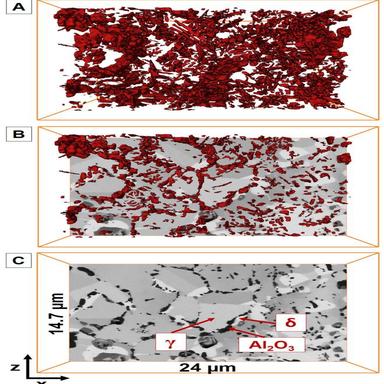
3D tomographic reconstruction of the distribution of the Al2O3 phase: A) top view; B) top view with an orthoslice inserted at the depth of 7 μm from the top; C) the orthoslice used to generate image 10B.